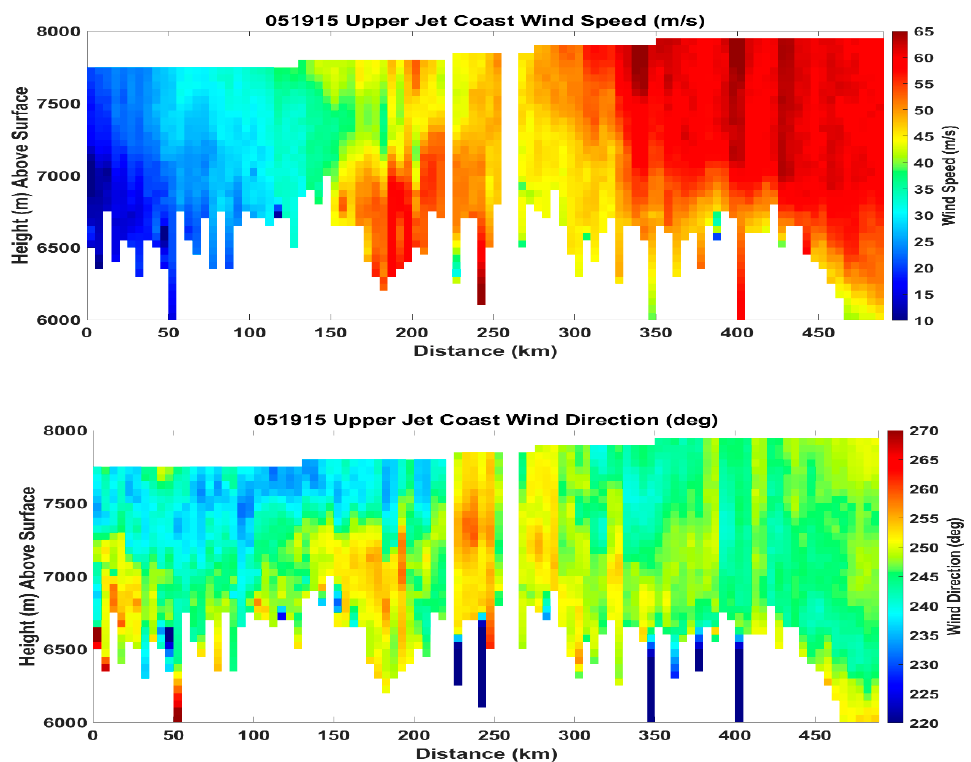
Figure 25. North–south x–z cross section of DAWN wind speed ( top ) and direction ( bottom ) for coastal flight segment off the east coast of Greenland on 19 May 2015.